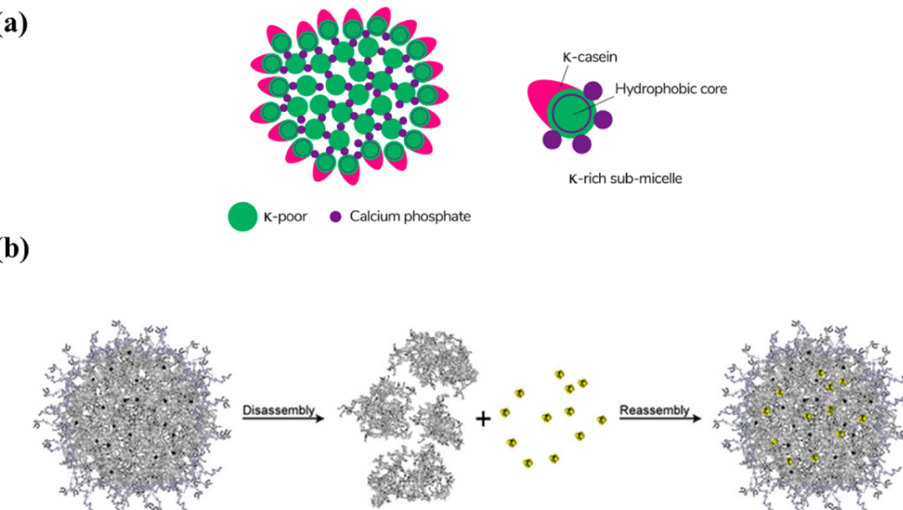
Figure 4. ( a ) The schematic of the submicelle model of the casein micelle. Reproduced with permission from ref. [93]. Copyright 2021 by the MDPI; ( b ) Graphical representation of the general principle behind reassembled casein nanospheres. Briefly, the micellar structure is disrupted, lipophilic compounds dissolved in organic solvents bind to hydrophobic regions of casein peptides; then caseins are reassembled, creating new, substance-loaded nanoparticles. Reproduced with permission from ref. [94]. Copyright 2017 by